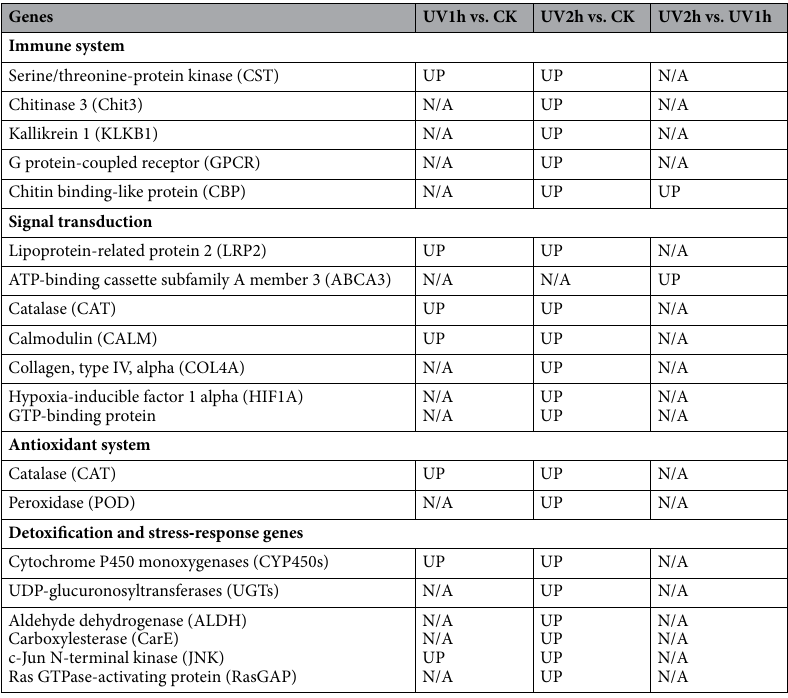
Table 2. List of DEGs in O. furnacalis under UV-A exposure. N/A not significantly changed, DEGs differentially expressed genes, UV